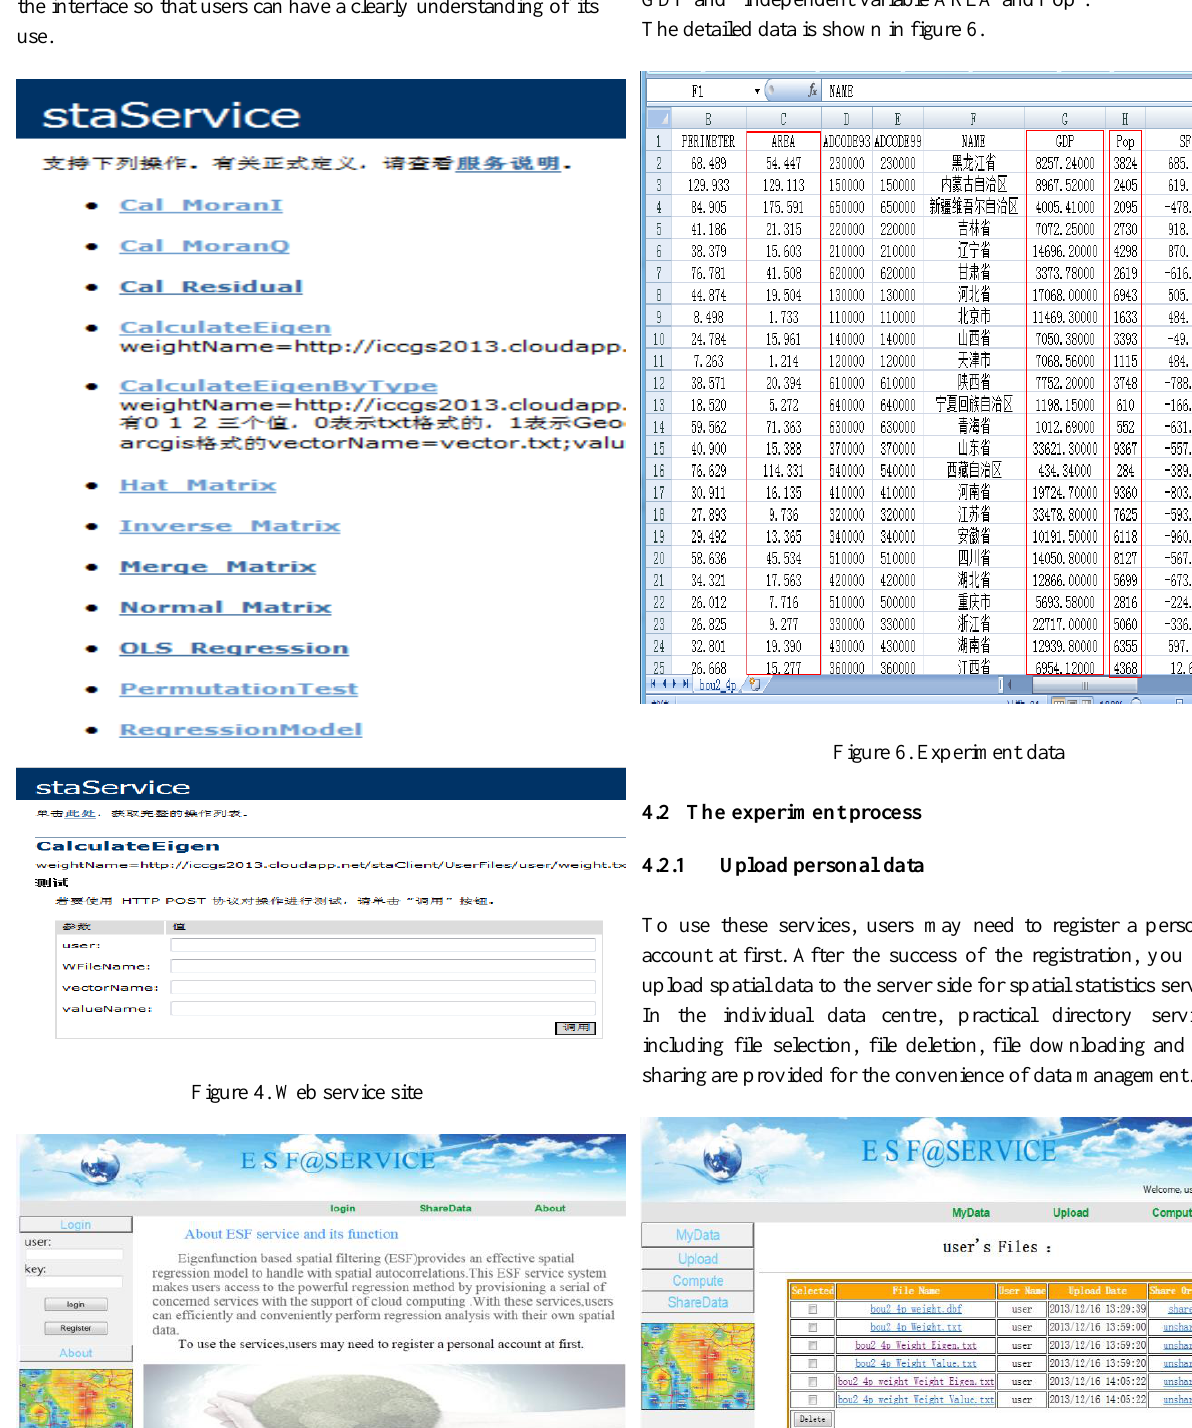
Figure 7. Personal data